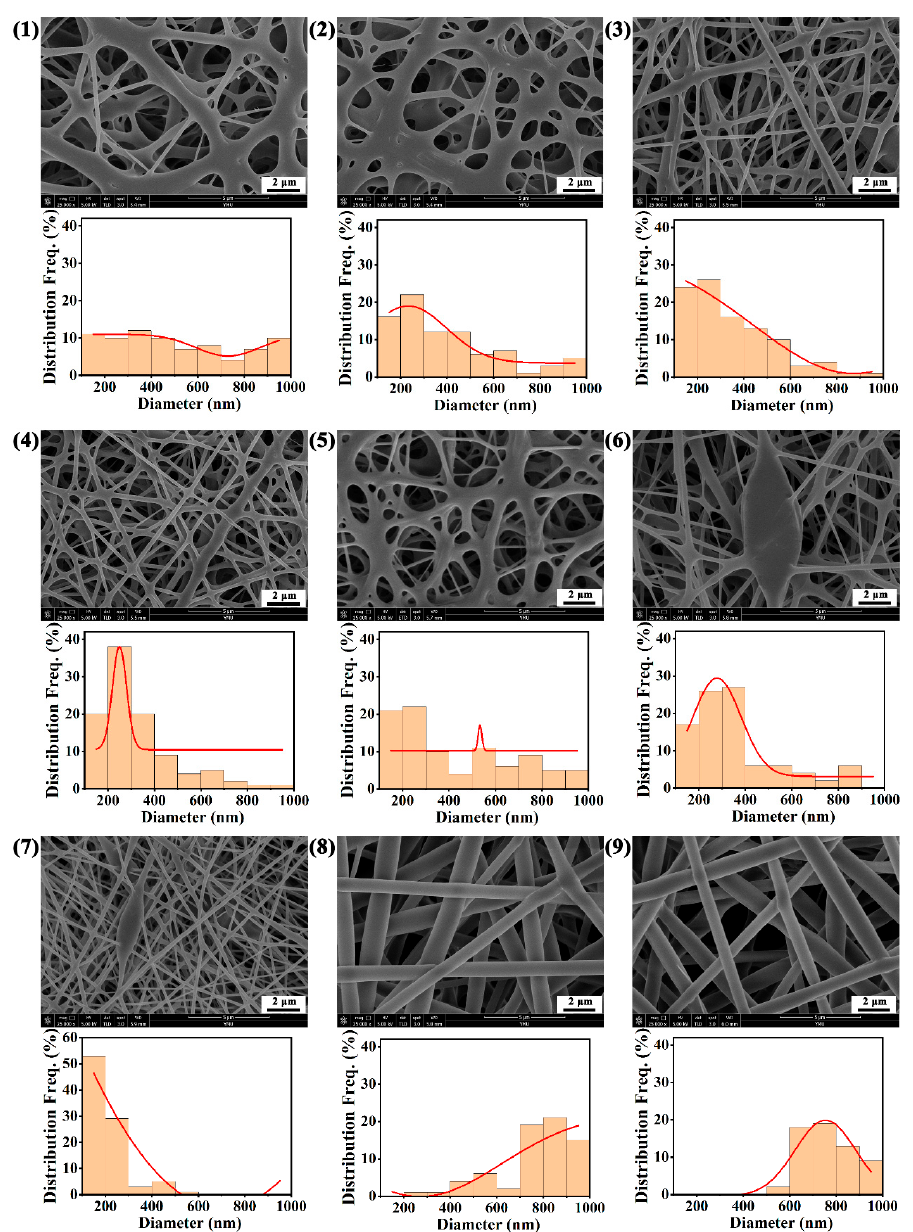
Figure 3. Microscopic morphology and diameter distribution of ZnO-PLLA/PLLA films in groups 1 to 9 .